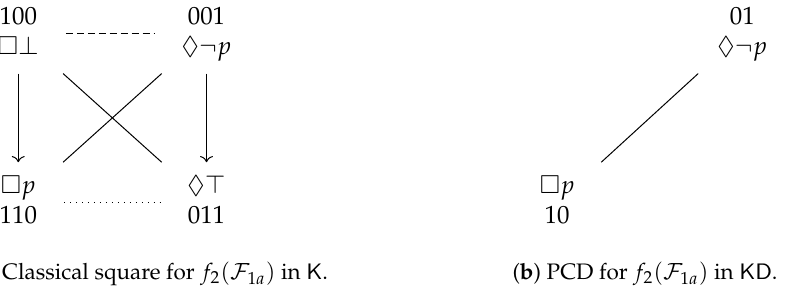
Figure 12. Aristotelian diagrams for f 2 ( F 1 a ) = { (cid:3) ⊥ , (cid:3) p , ♦ ¬ p , ♦ (cid:62)} in two normal modal logics.